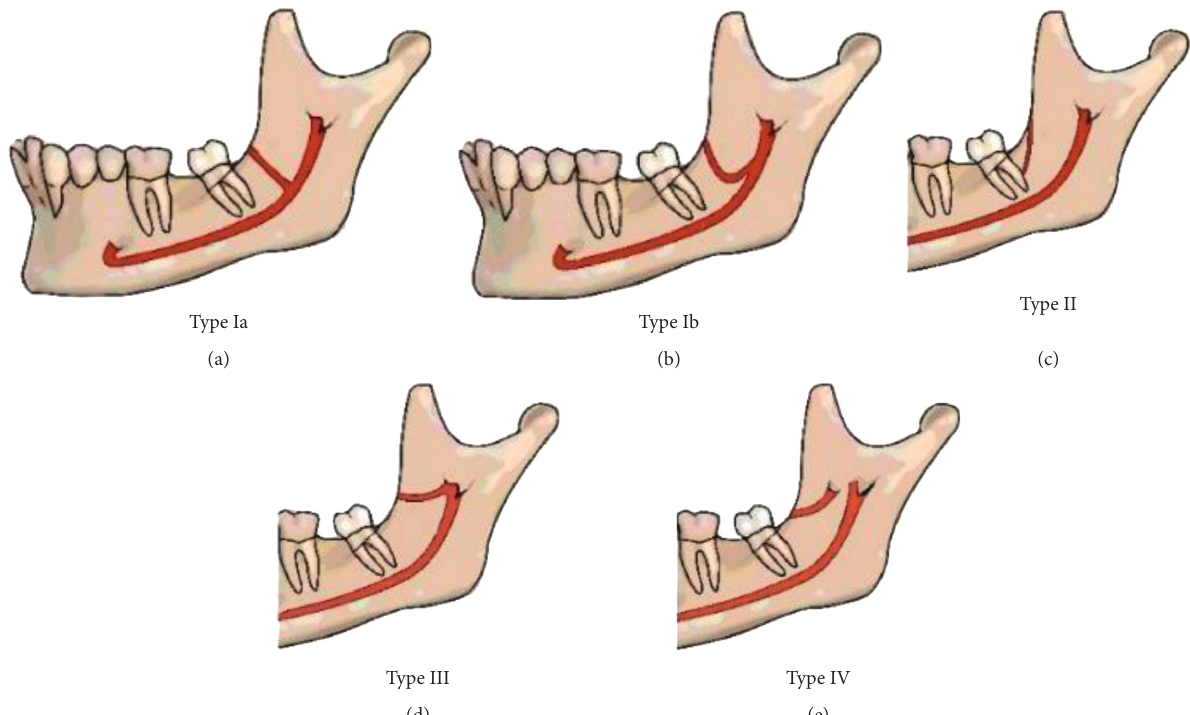
Figure 1: The four types of retromolar canals are as follows: Type I . The retromolar canal originates from the mandibular canal and courses toward the retromolar fossa through (a) a straight (Ia) or (b) a curved (Ib) trajectory. (c) Type II . The retromolar canal courses between the retromolar fossa toward the root portion of the third molar, with no connection with the mandibular canal. (d) Type III . The retromolar canal originates from the mandibular foramen and courses forward to the retromolar fossa. (e) Type IV . The retromolar canal originates from a foramen other than mandibular foramen and courses anteriorly toward the retromolar